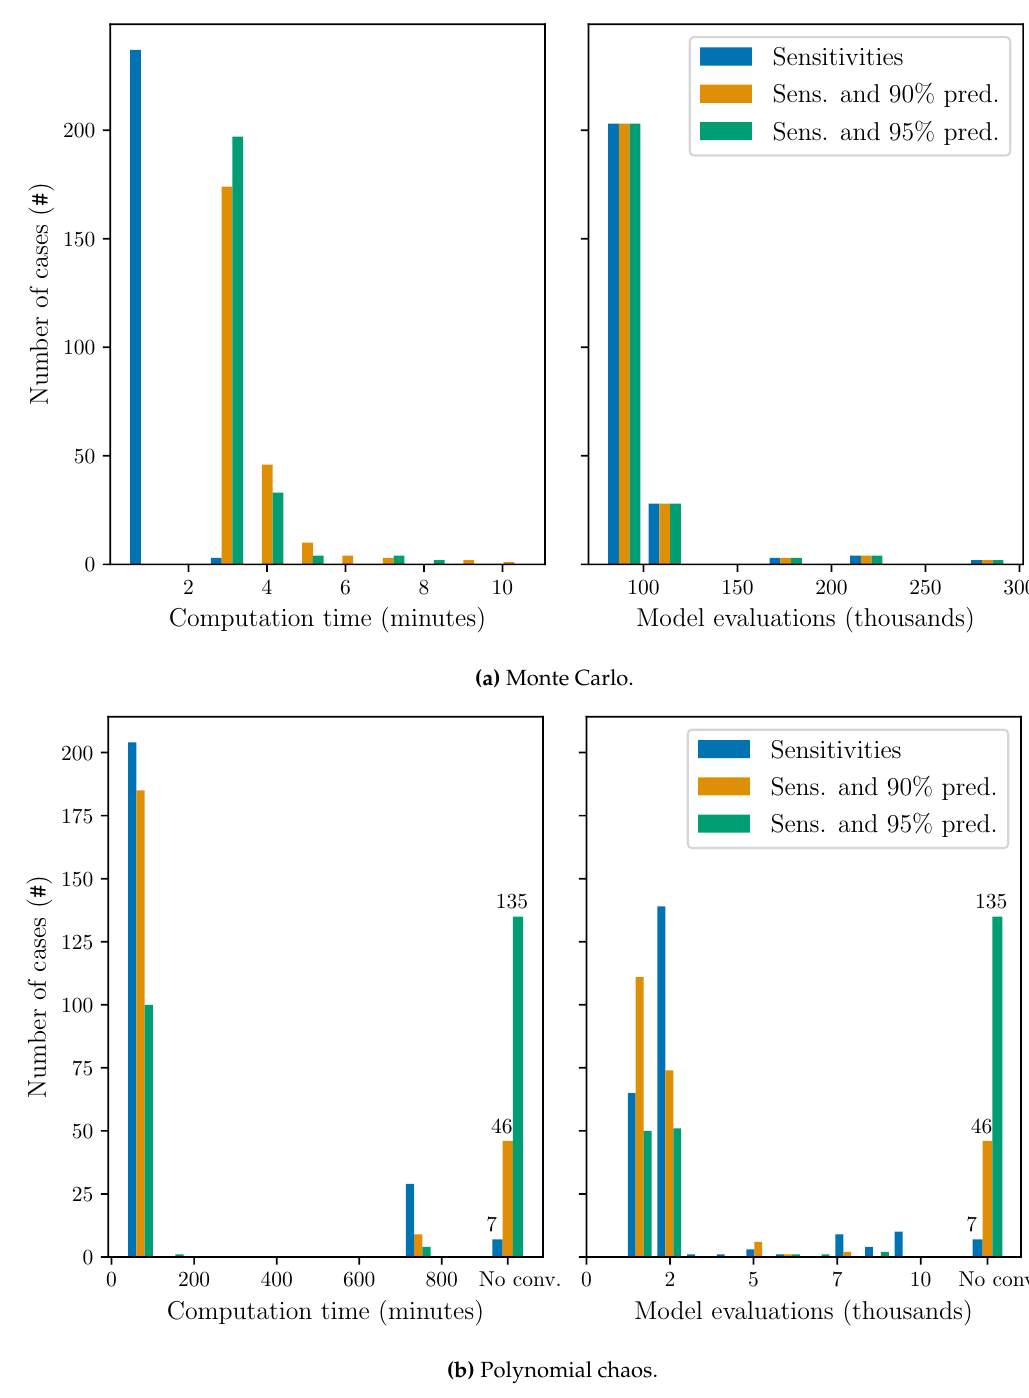
Figure 10. Frequency histogram of computational cost across 240 experiments. Each color is one type of simulation criterion, namely only convergence in sensitivities (blue) or also 90% prediction intervals (orange) or 95% (green). The number of cases that did not converge is given as an entry on the right. Left : Computation time. Right : Number of model evaluations.